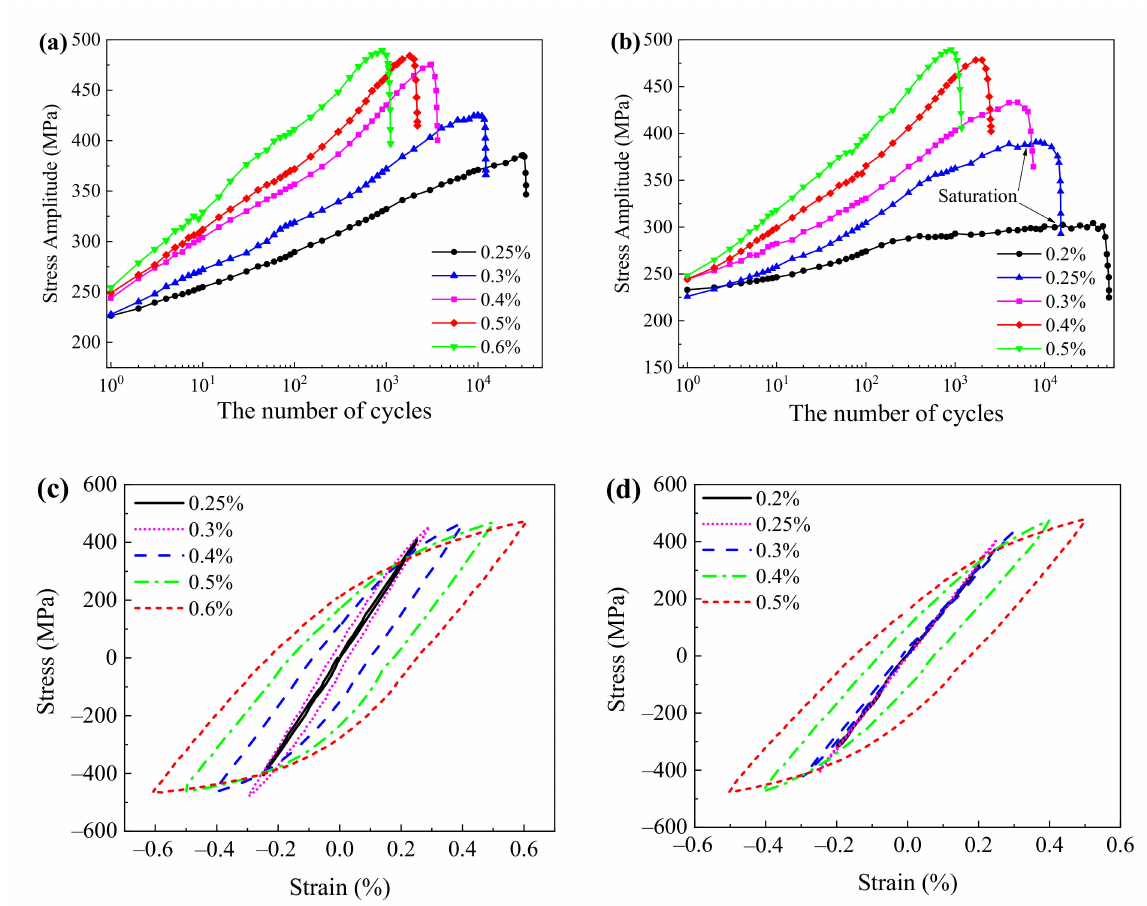
Figure 4. Cyclic stress amplitude response curves at ( a ) 700 ◦ C and ( b ) 800 ◦ C, and the half-life hysteresis loops at ( c ) 700 ◦ C and ( d ) 800 ◦